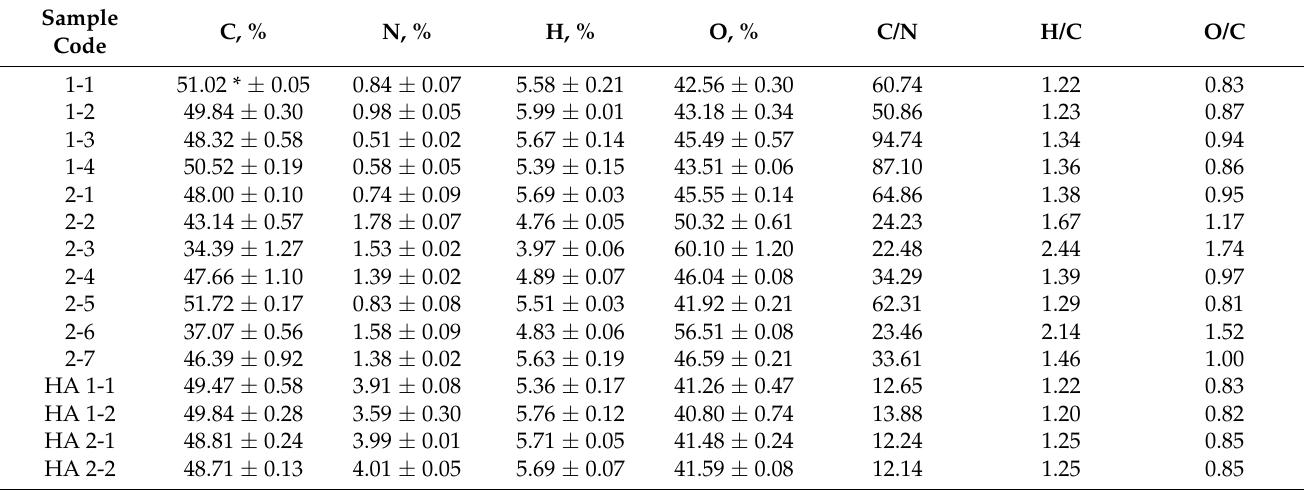
Table 3. Elemental composition of humic acids and organic